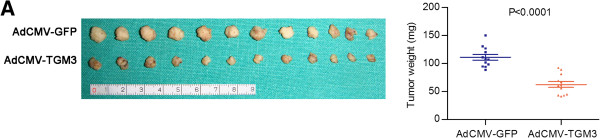
The effect of TGM3 on tumorigenicity in vivo. (A) Exogenous TGM3 expression inhibited xenograft tumor growth of HN30 cells treated with AdCMV-TGM3 relative to HN30 cells treated with AdCMV-GFP. Tumors’ weights were measured (mean ± SD).